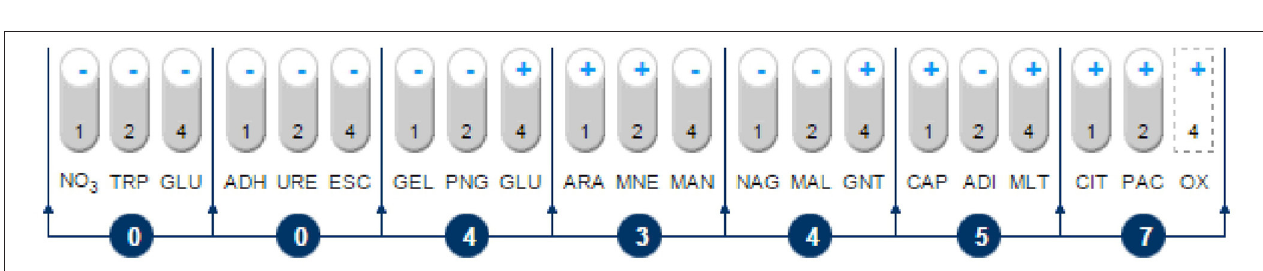
FIGURE 3 | Biochemical pattern and numerical profile of the isolated strain MC1. NO 3, potassium nitrate; TRP, L-tryptophan; GLU, D-glucose (fermentation); ADH, L-arginine; URE, urea; ESC, esculin; GEL, gelatin; PNG, 4-nitrophenyl- β -D-galactopyranoside; GLU, D-glucose; ARA, L-arabinose; MNE, D-mannose; MAN, D-mannitol; NAG, N -acetyl-glucosamine; MAL, D-maltose; GNT, potassium gluconate; CAP, capric acid; ADI, adipic acid; MLT, malic acid; CIT, trisodium citrate; PAC, phenylacetic acid; OX,